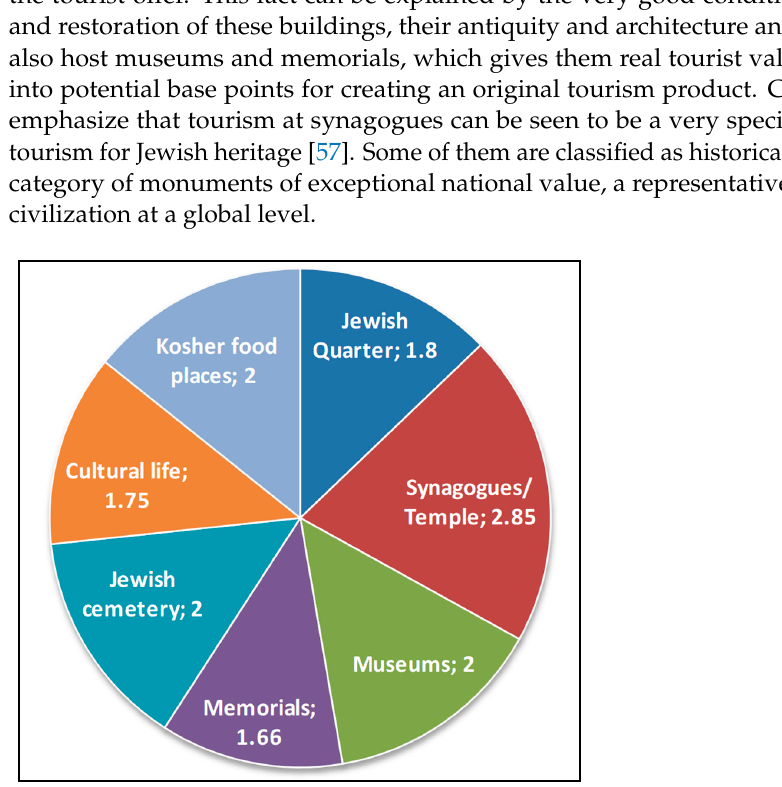
Figure 6. The participation of each component element in the Jewish cultural heritage tourism product.